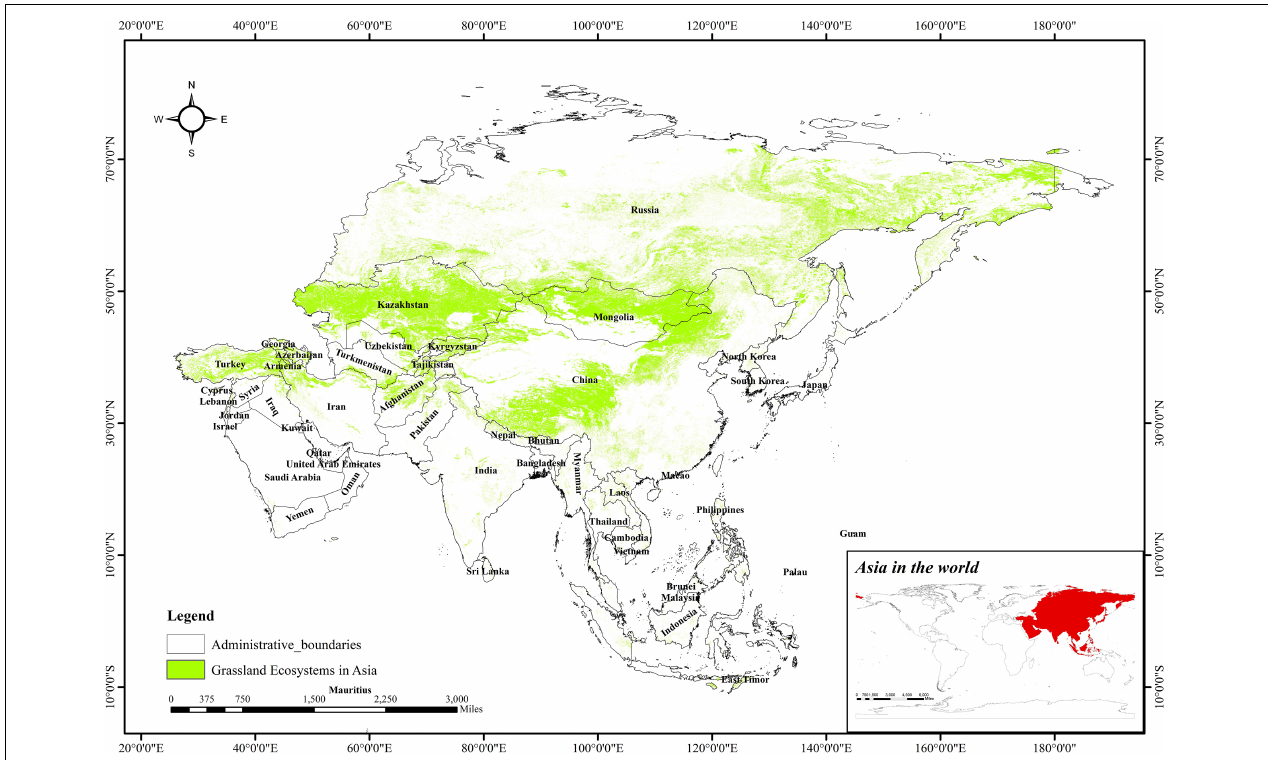
FIGURE 1 | Location and topography of the study area (The boundaries, names, and designations are for illustrative purposes only and do not represent an official